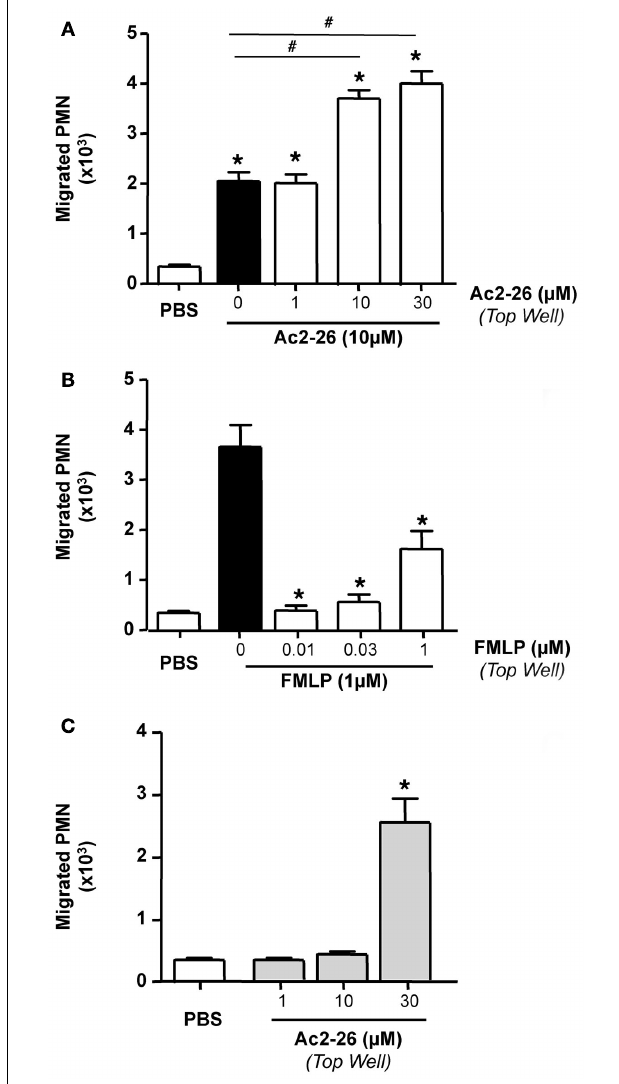
FIGURE 2 | PeptideAc2-26, but not FMLP, induces PMN chemokinesis. Peripheral blood neutrophils were incubated with either (A) peptide Ac2-26 (1–30 μ M) or PBS prior to loading on to 96 well ChemoTx™ plate where the bottom wells were either loaded with peptide Ac2–26 (10 μ M) or (B) FMLP (0.01–1 μ M) prior to loading on to a chemotaxis plate in the presence of 1nM FMLP. (C) Neutrophils were incubated with peptide Ac2-26 (1–30 μ M) prior to loading on to the chemotaxis plate. Results are ± SEM from three to four cell preparations [ (A,B) * P < 0.05 vs. stimulus alone (dose 0 group); (C) * P < 0.05 vs. PBS].